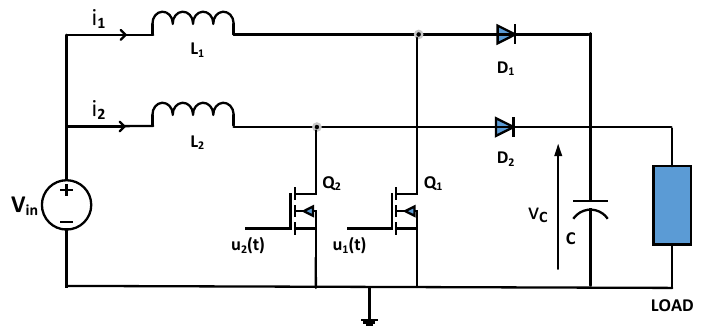
Figure 6. The two-stage interleaved boost converter